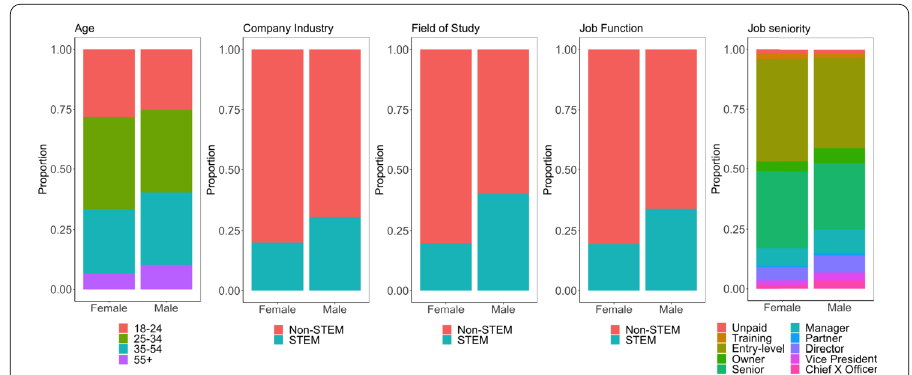
Figure 3 Gender composition of different characteristics among LinkedIn